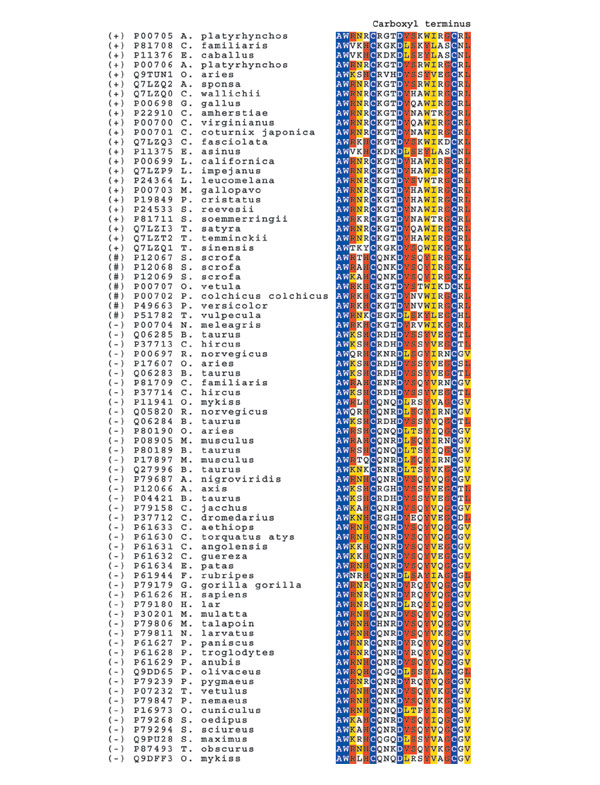
Multiple alignment of lysozyme carboxyl termini. A screen of the SWISS-PROT database [15] for proteins that harbour PTS1 signals produced a set of lyosozymes, well characterized secreted enzymes that are not usually found in peroxisomes. Rather than occurring sporadically, a large fraction of the known sequences from this family was obtained using the PTS1 prediction tool [7]. Moreover, these hits could not be rationalized as false positives as they did not deviate from the PTS1 sequence motif [11-13]. The multiple alignment shows intact vertebrate lysozyme carboxy-terminal 20-mers (with accession number and species name) retrieved from the SWISS-PROT database. From a total of 76 entries, 23 have predicted PTS1s (score > 0; at the top, marked with '+'), seven are in the twilight zone (-10 < score < 0; in the middle, marked with '#') and 46 are not predicted (score < -10; at the bottom, marked with '-'). There appears to be an overlap between the PTS1 motif and sequence variability within the lysozyme family. For example, the absolutely conserved cysteine near the carboxyl terminus is needed for the formation of a disulfide bridge in the mature protein [21]. This cysteine also meets the requirement for a small residue at the antepenultimate position of the PTS1 sequence.